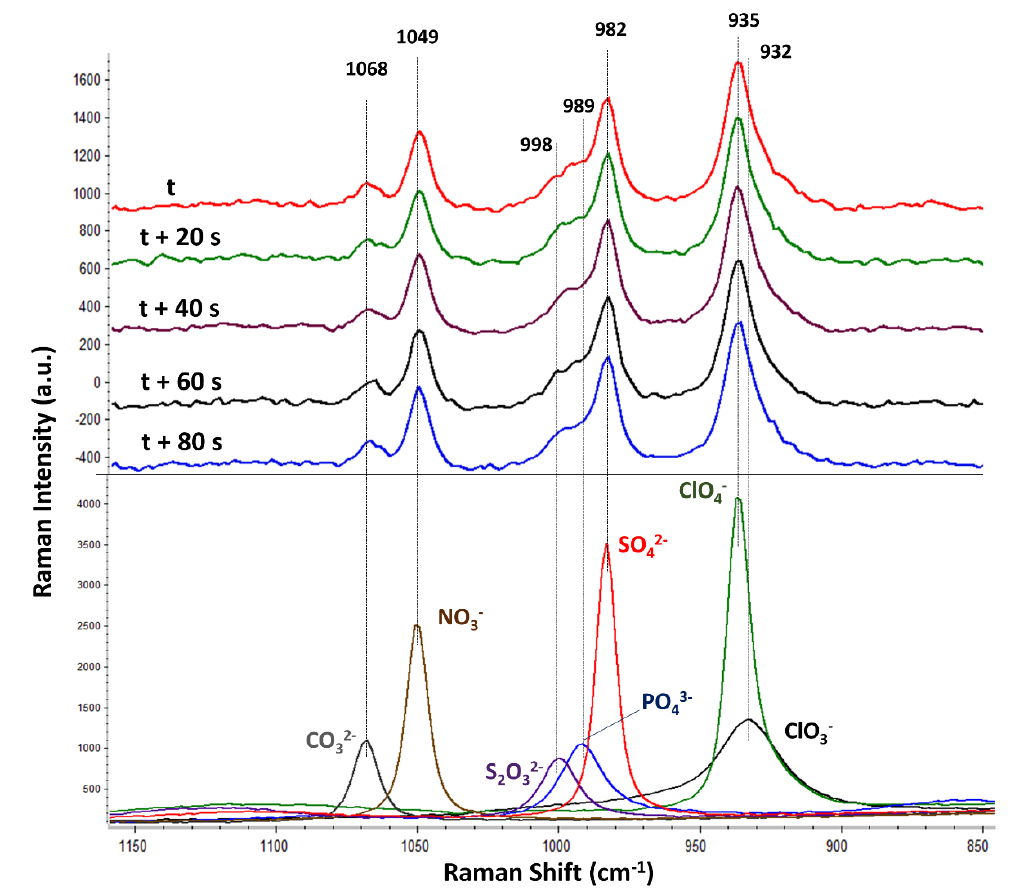
Figure 3. Average Raman spectra (from five replicates) of separately analysed standard solutions of carbonate, nitrate, thiosulphate, hydrogen-phosphate, sulphate, perchlorate, or chlorate, the individual concentrations of which were 0.5 mol/L each (bottom); five consecutive spectra (every 20 s) of the solution containing a mixture of the seven oxyanions, the concentration of which was 0.15 mol/L per oxyanion (top). Two scales are used: one for the standard oxyanion solutions (bottom) and another for the sample mixture containing the seven oxyanions (top). The five time-consecutive spectra of the mixture solution are vertically offset for clarity.